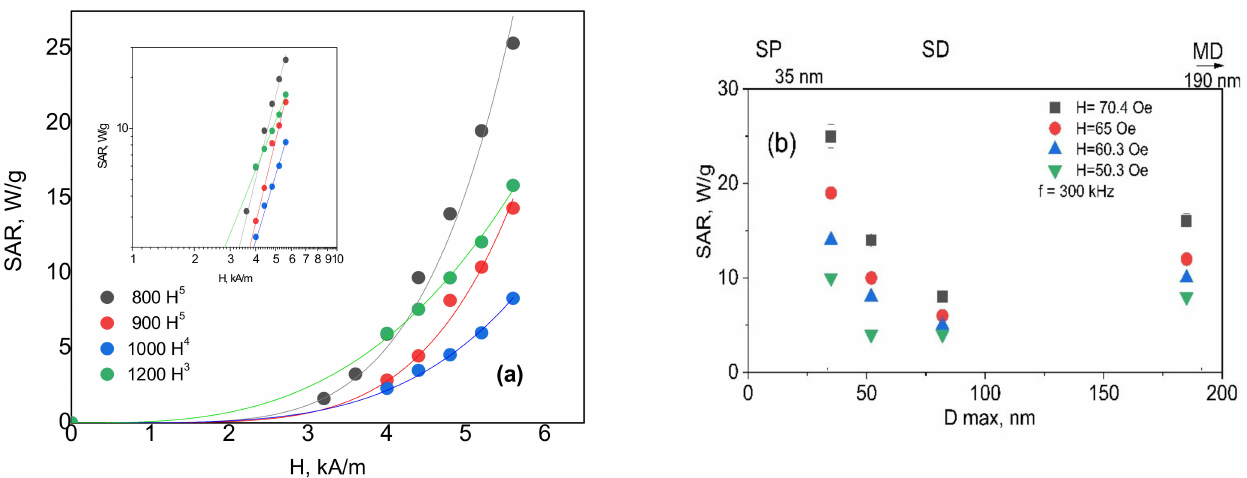
Figure 11. The dependencies of estimated SAR on magnetic field amplitude at a frequency of 300 kHz (the insert—the logarithmic scale) ( a ) and on particle sizes at different magnetic field amplitudes ( b ). SP—superparamagnetic state, SD—single domain state, and MD—multi-domain